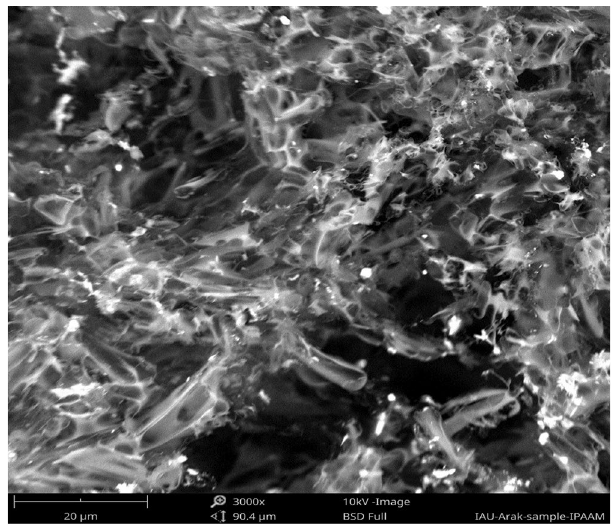
Figure 19. SEM image of difunctionalized PNIPAAM with magnification 3000.